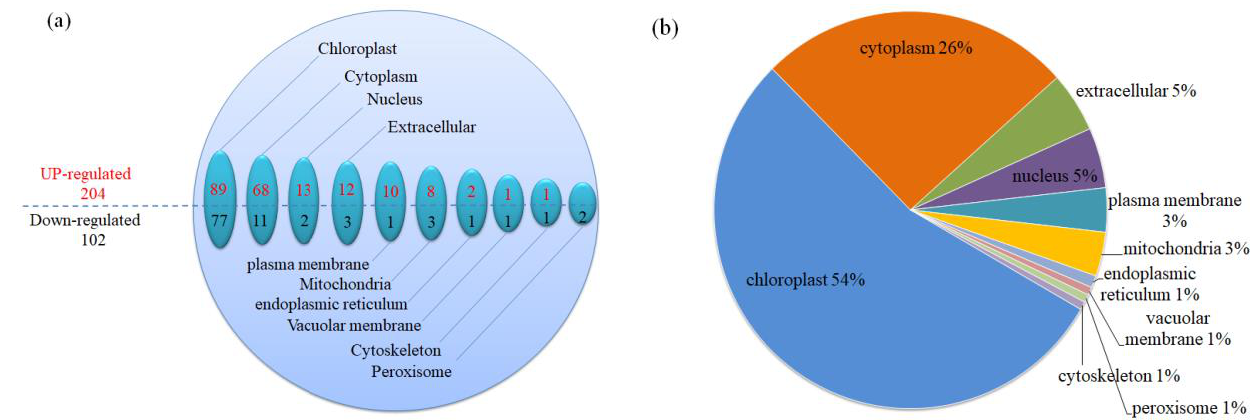
Figure 5. Subcellular structure localization and distribution of up-regulated and down-regulated proteins in G164 compared to C1.Note: Location and number of up- regulated and down-regulated proteins in the subcellular ( a ), and Location and ratio of differential proteins in the subcellular ( b ).